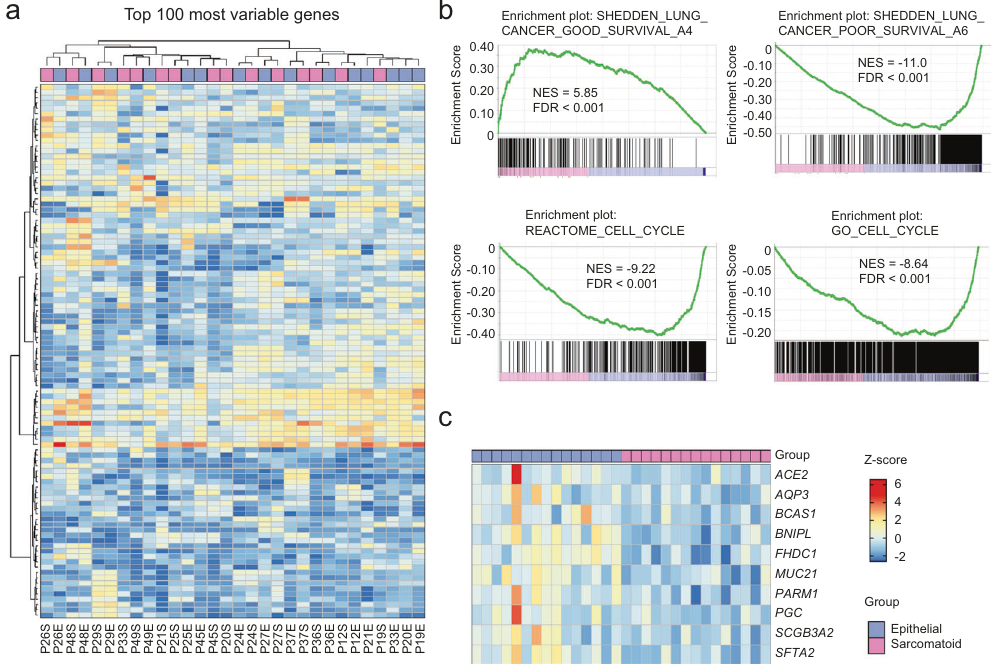
Fig. 4 Comparison of RNA expression patterns between epithelial and sarcomatoid components. a Heat map of the z-scores of the top 100 genes differentially expressed between the epithelial and sarcomatoid components. b Gene Set Enrichment Analysis revealed that the “ SHEDDEN_LUNG_CANCER_POOR_SURVIVAL_A6 ” set was signi fi cantly enriched in the sarcomatoid group, whereas the “ SHEDDEN_LUNG_- CANCER_GOOD_SURVIVAL_A4 ” set was enriched in the epithelial group. Cell cycle-related gene sets were signi fi cantly enriched in the epithelial group. c Heat map of the z-scores of 10 genes that were differentially expressed between epithelial and sarcomatoid components. All genes were more strongly expressed in the epithelial group. FDR, false discovery rate; NES, normalized enrichment